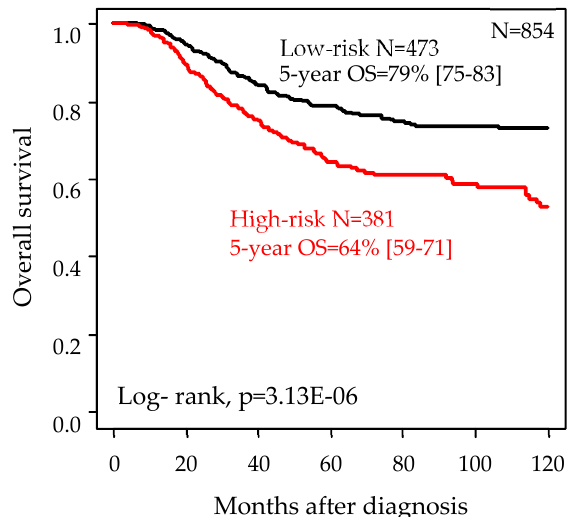
Figure 3. Kaplan–Meier overall survival (OS) curves according to the 13-gene classifier.